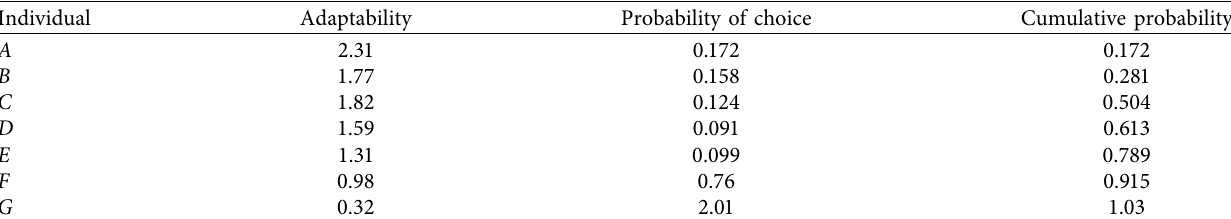
Table 2: Particle fitness of ferroelectric